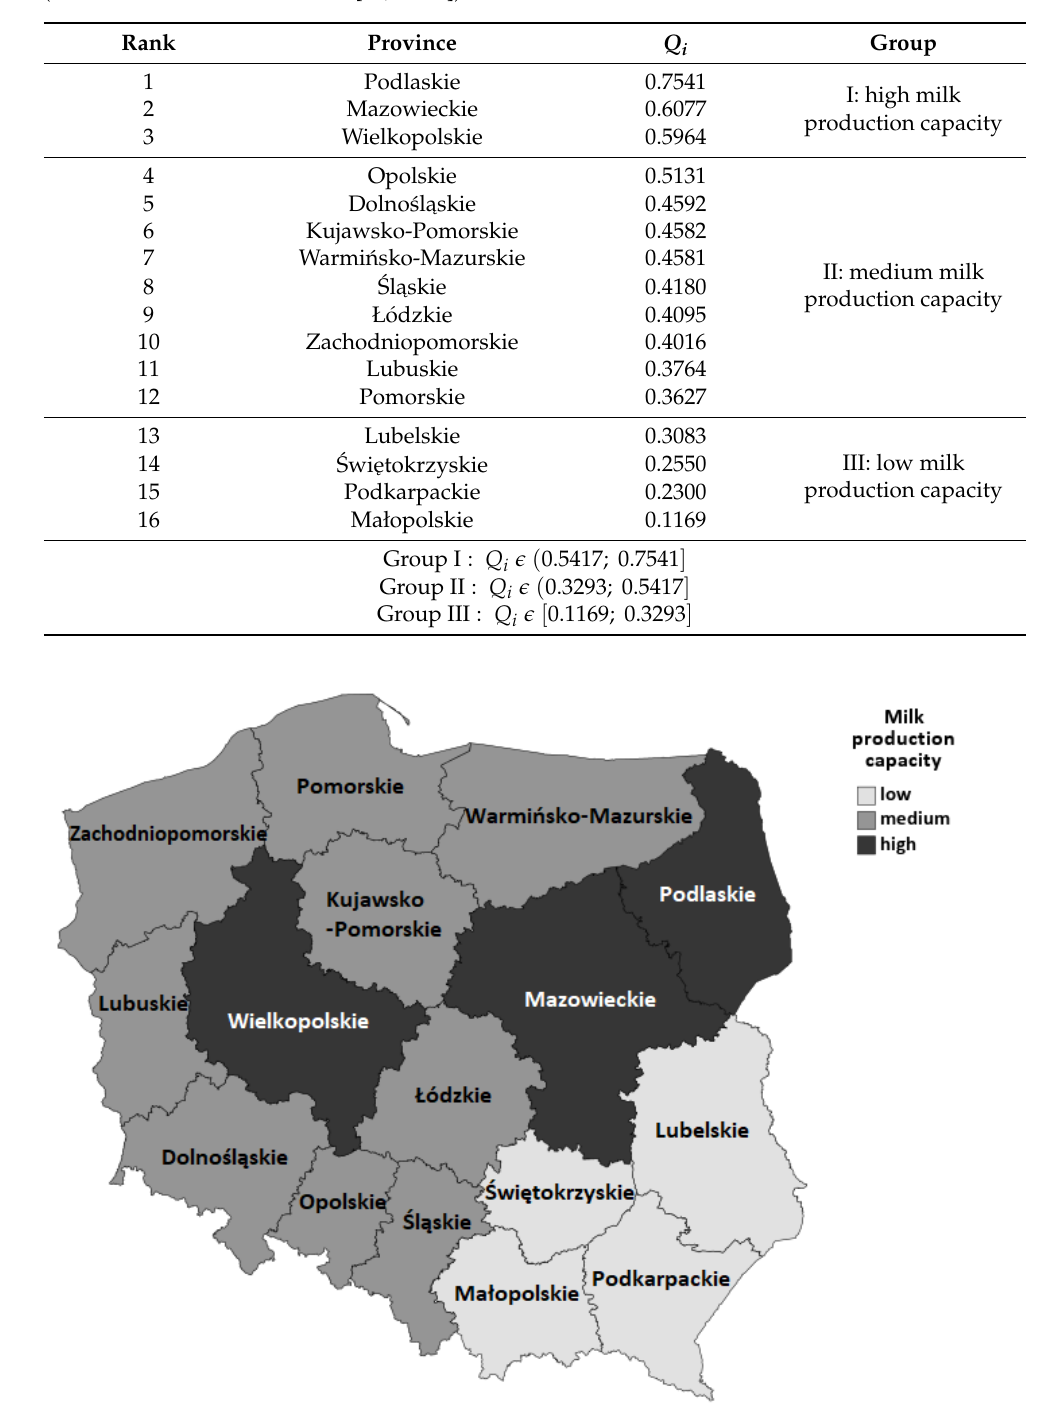
Table 12. Values of the synthetic variable and classification of provinces by milk production capacity (authors’ calculations based on [35,89–91]).